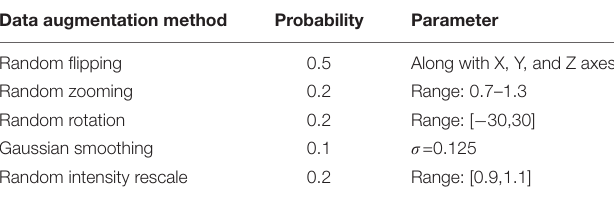
TABLE 1 | Data augmentation methods adopted in our proposed